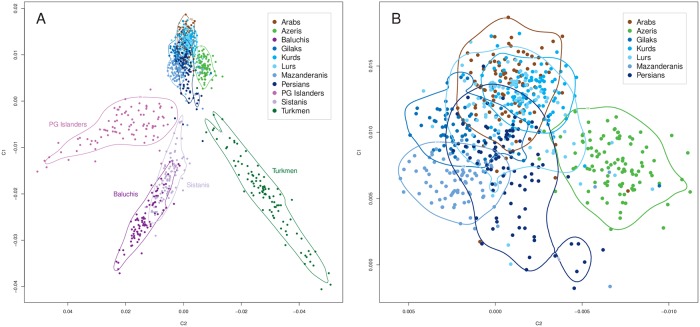
Internal Iranian population structure.Relative sample locations with respect to the first two MDS components. (A) Relative sample locations of the Iranian ethnic groups from this study, including 90% density limits; (B) zoomed view into the subset of the seven groups belonging to the Central Iranian Cluster (CIC).